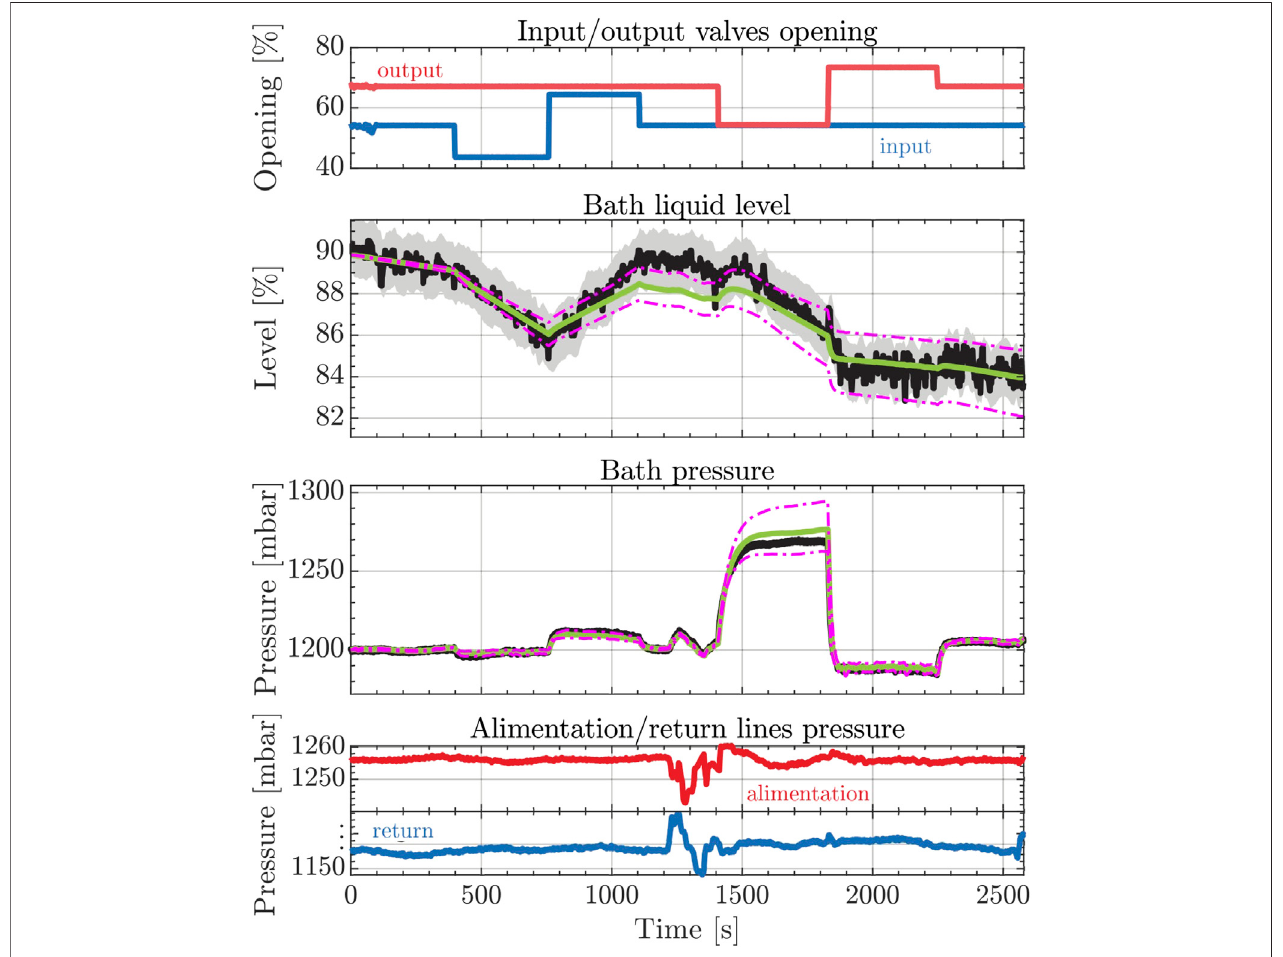
FIGURE2| Modelvs.measurementforthe fi rsttype-Acryomodule.Measurementandassociateduncertaintyare,respectively,representedbyblacklineandgray background. Simulation value and uncertainty are, respectively, represented by green lines and magenta dash-dotted lines.